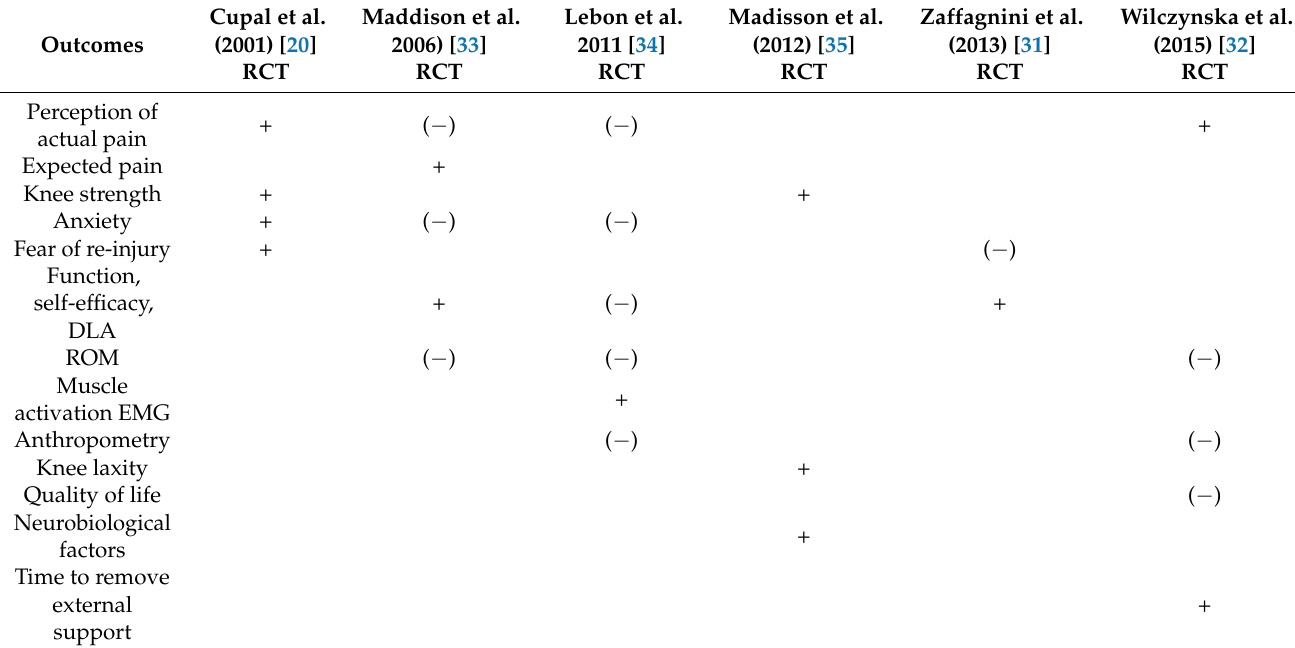
Table 2. Outcomes subgroup